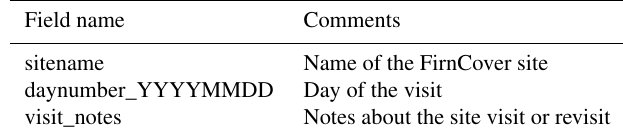
Table A6. Station_Visit_Notes table.